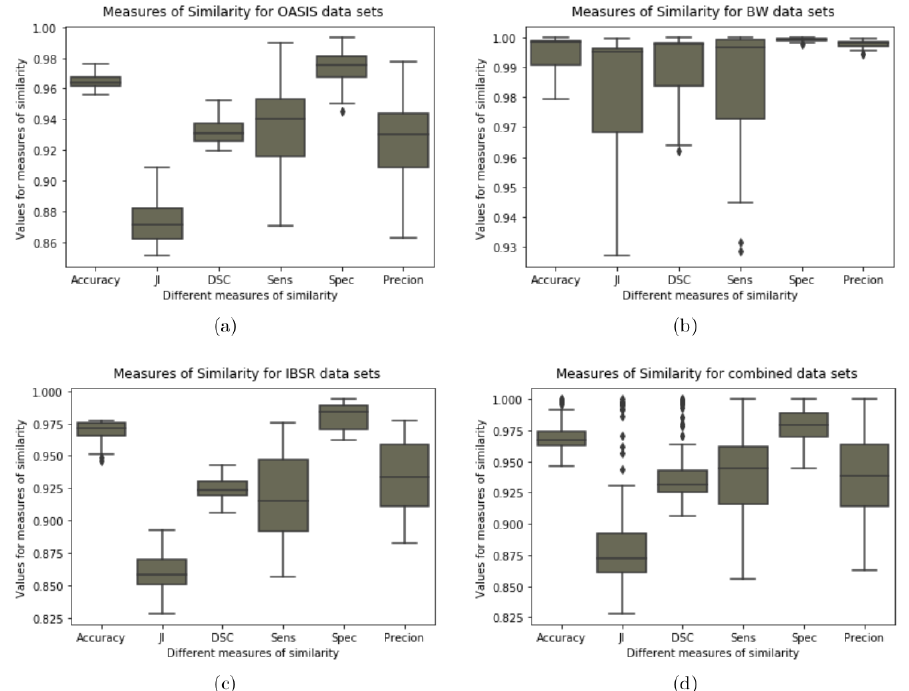
Figure 12. Boxplot for the measures of similarity (Combined Data sets): Boxplot showing variability for the measures of similarity for the results obtained using GUBS method across the combined data sets. JI = Jaccard Indices, DSC = Dice Similarity coefficients, Sens = Sensitivity, Spec = Specificity.